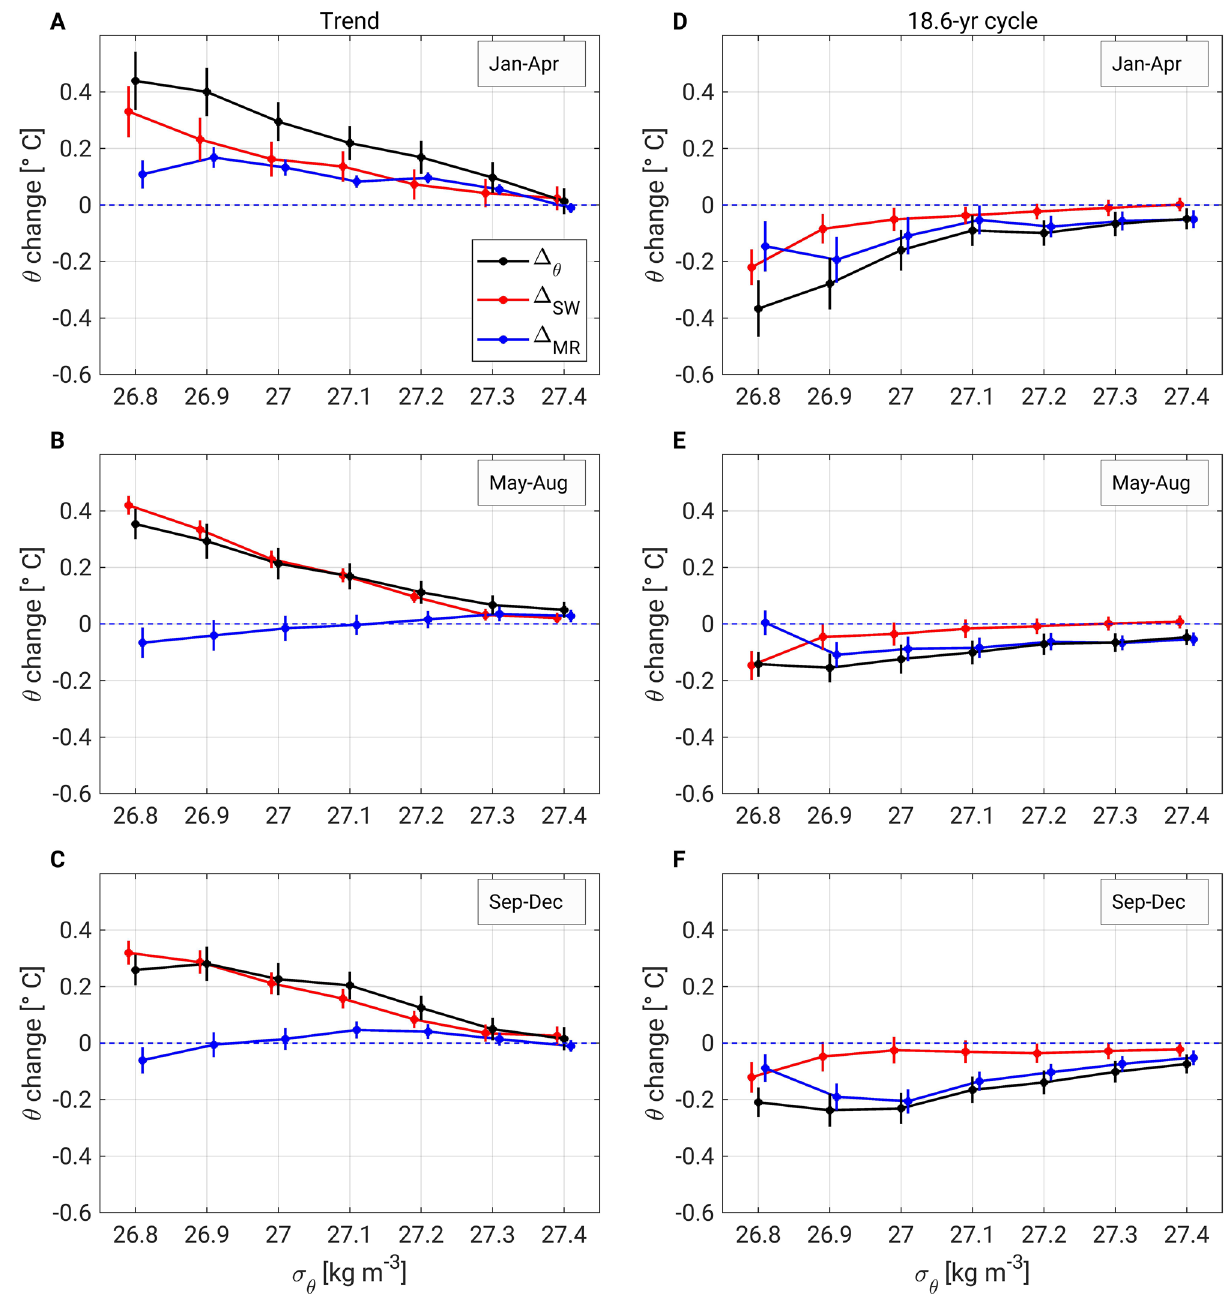
Figure 7. Potential temperature changes in OYW and their contributing factors. Changes in OYW potential temperature (black) and the contribution to these variations by changes in the mixing ratio (Δ MR , blue) and changes in the source water properties (Δ SW , red) from ( A , D ) January to April, ( B , E ) May to August, and ( C , F ) September to December. Panels ( A – C ) represent the changes due to the long-term trend and ( D – F ) the changes due to the 18.6-year tidal cycle. The error bars represent the 95% confidence interval (see “Methods” for details on the confidence interval calculation). The data points and corresponding error bars are slightly shifted horizontally for